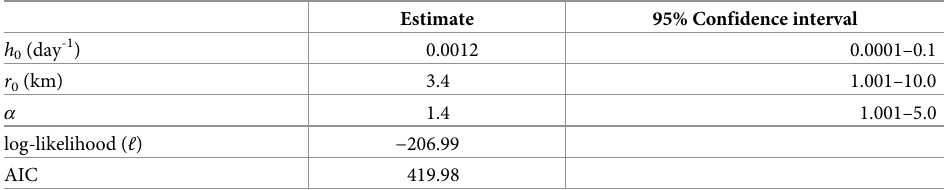
Table 1. Maximum likelihood estimation and 95% confidence intervals of the transmission parameters.